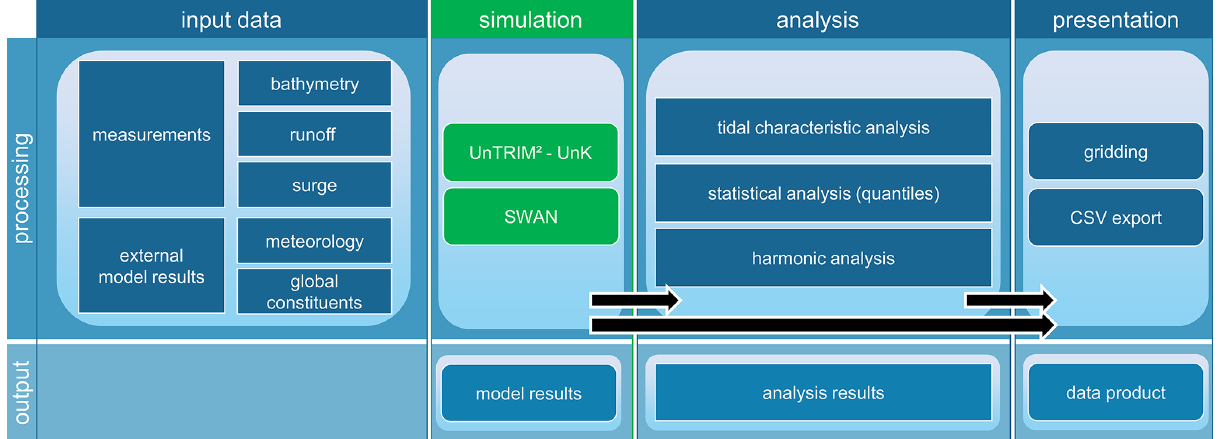
Figure 2. Data product lineage (from left to right) from origin (input data), to numerical modeling (simulation), data analysis, and final presentation. The processing row indicates the data operations and tools used to produce the indicated output row. The output row defines the data state starting with unstructured modeling results followed by unstructured analysis results, and final gridded data products.